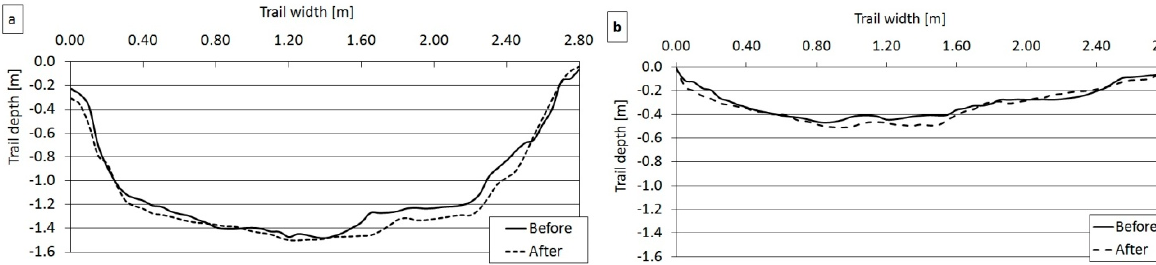
Table 5. Average and maximum ground slope in the central 1.5-m-wide section of the trail before (T1) and after timber skidding (T2).